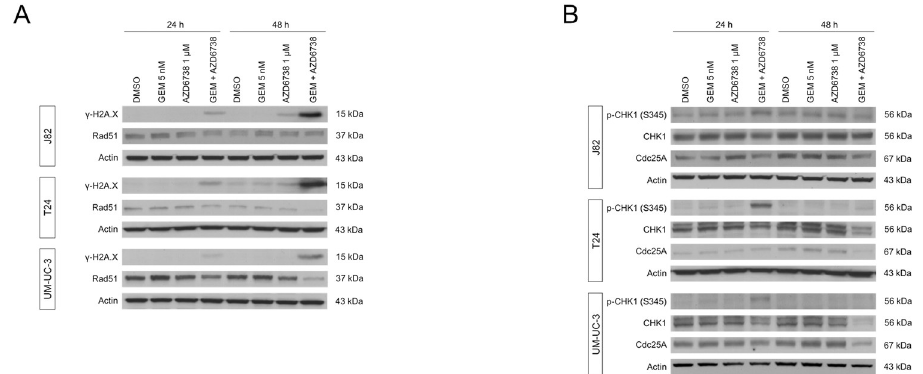
Fig 4. Western blot analysis of checkpoint factors. Whole cell lysates from bladder cancer cells treated with gemcitabine (5 nM) and/or AZD6738 (1 μ M) for 24 or 48 hours were assayed for the indicated proteins or their phosphorylation. As loading controls, actin was stained on each